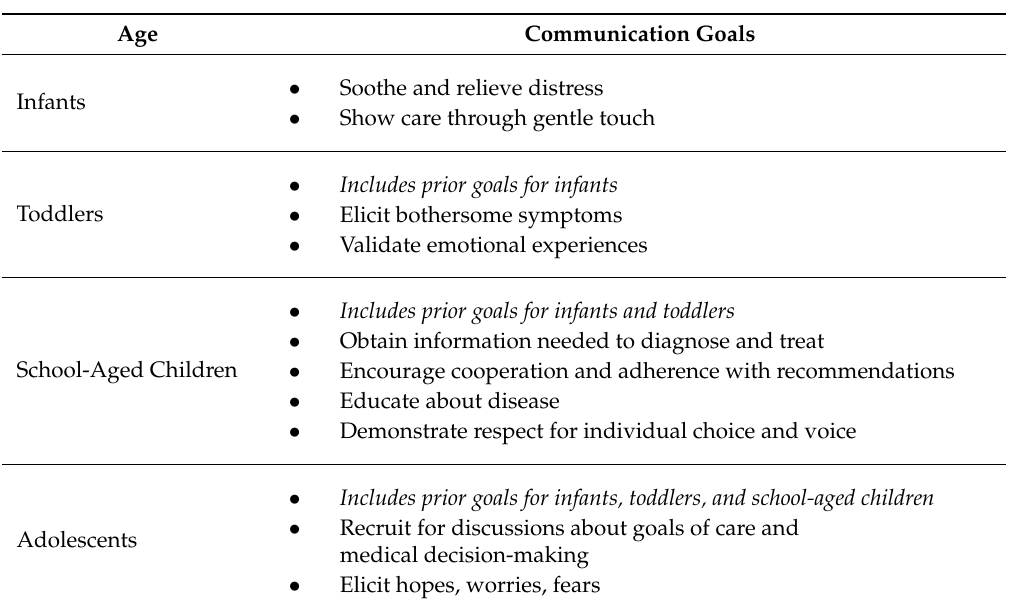
Table 5. Communication goals by patient